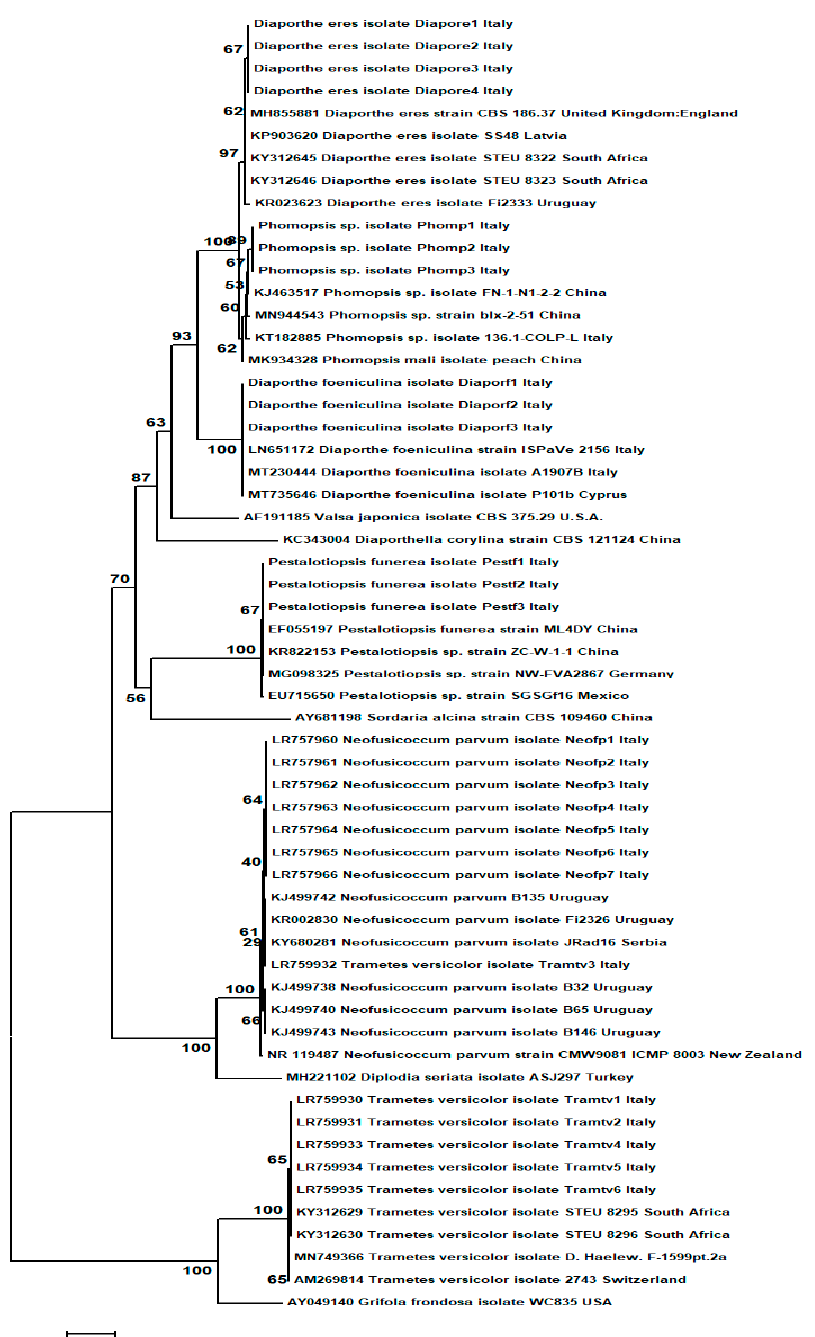
Figure 2. Molecular phylogenetic tree obtained through the neighbor-joining (NJ) method, based on the 58 ITS region sequences data (658 bp) from fungal isolates in the present study and published sequences. Five fungal species ( Diaporthella corylina , Valsa japonica , Sordaria alcina , Grifola fondosa and Diplodia seriata ) were used as outgroups in the analysis. The optimal tree with the sum of branch length = 1.38532669 is shown. The confidence probability estimated using the bootstrap test (1000 replicates) is shown next to the branches. The tree is drawn to scale, with branch lengths in the same units as those of the evolutionary distances used to infer the phylogenetic tree. The evolutionary distances were computed using the Tajima–Nei method and are in the units of the number of base substitutions/site. Scientific names of the fungi along with collection place, isolate abbreviation and GenBank AC number are shown in the